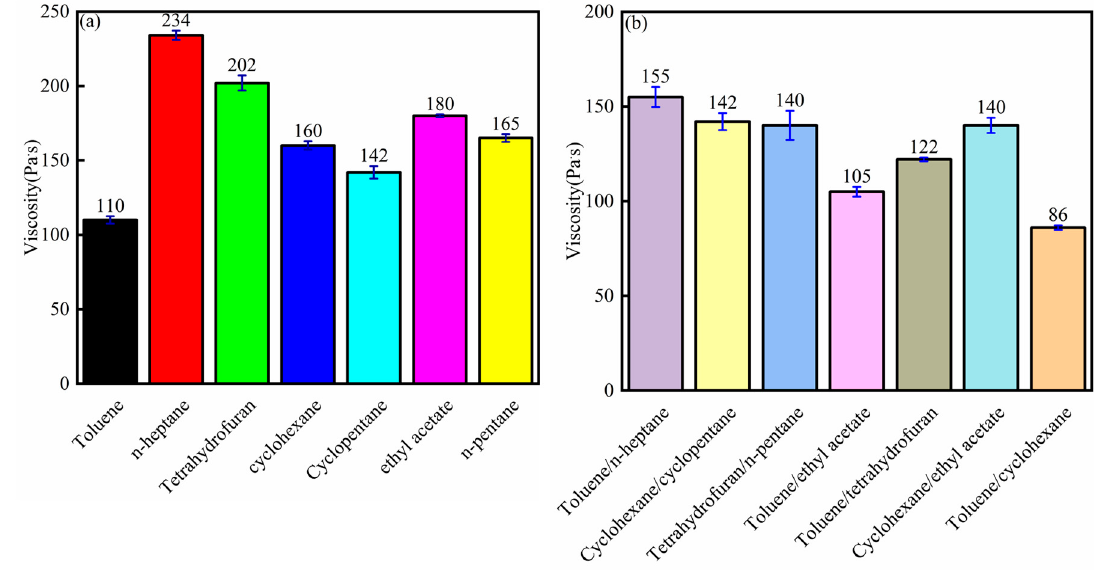
Figure 9. Viscosity analysis of bitumen from ( a ) single solvent extraction; ( b ) composite solvent extraction.